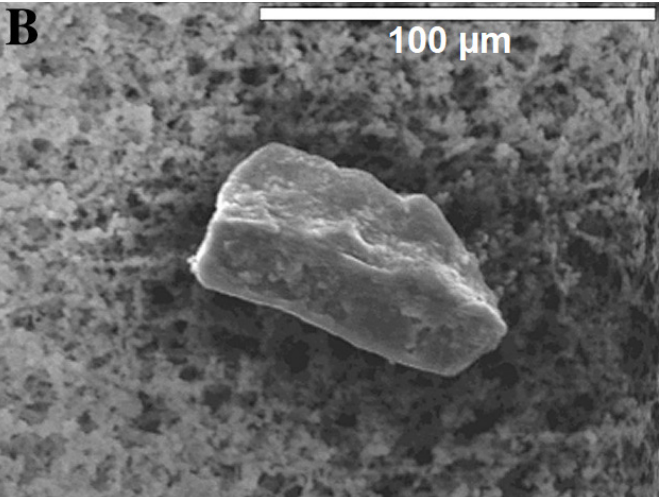
Figure 2. Particle extracted from deep sea sediment in the Porcupine Abyssal Plain by van Cauwen- berghe et al., 2013, Reprinted with permission from ref. [48], Copyright 2013 Elsevier.